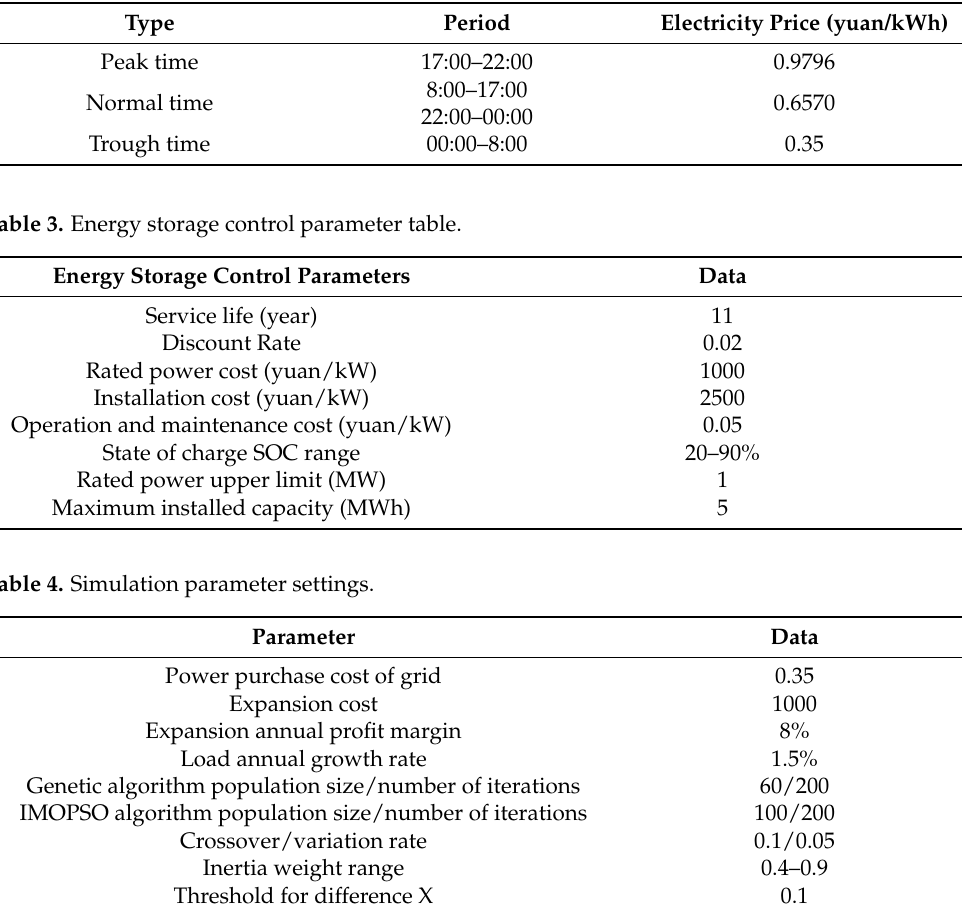
Table 2. Time-of-use electricity price table.